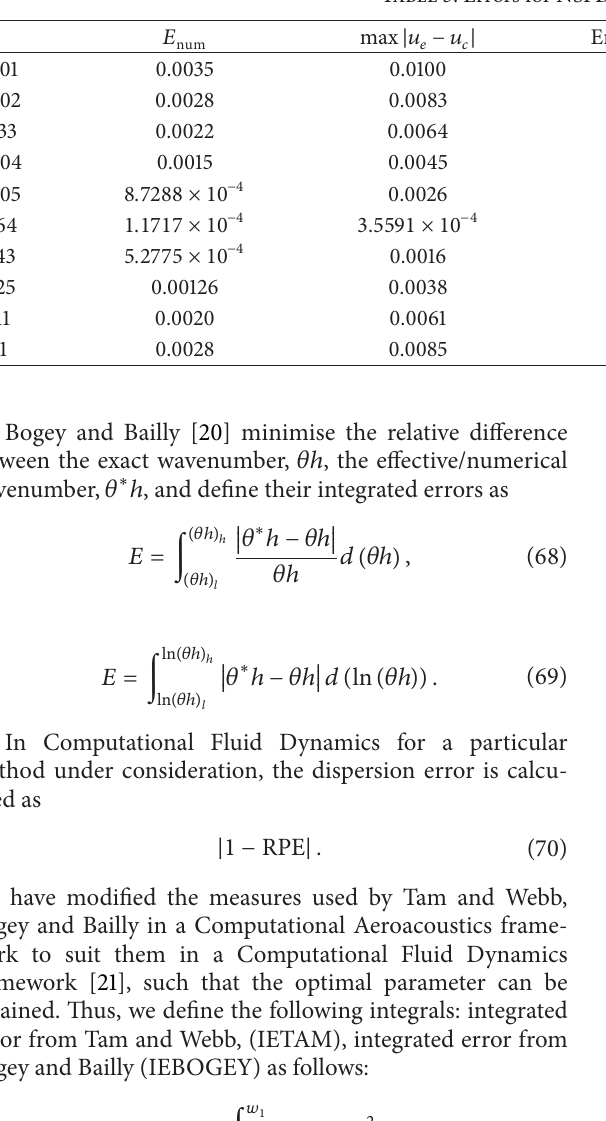
Table 5: Errors for NSFD scheme for ℎ = 0.02